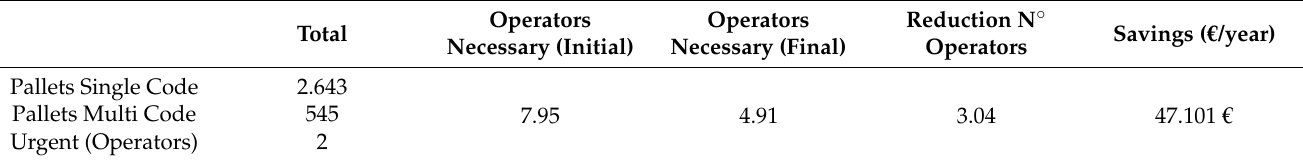
Table 11. Project savings in November 2020.